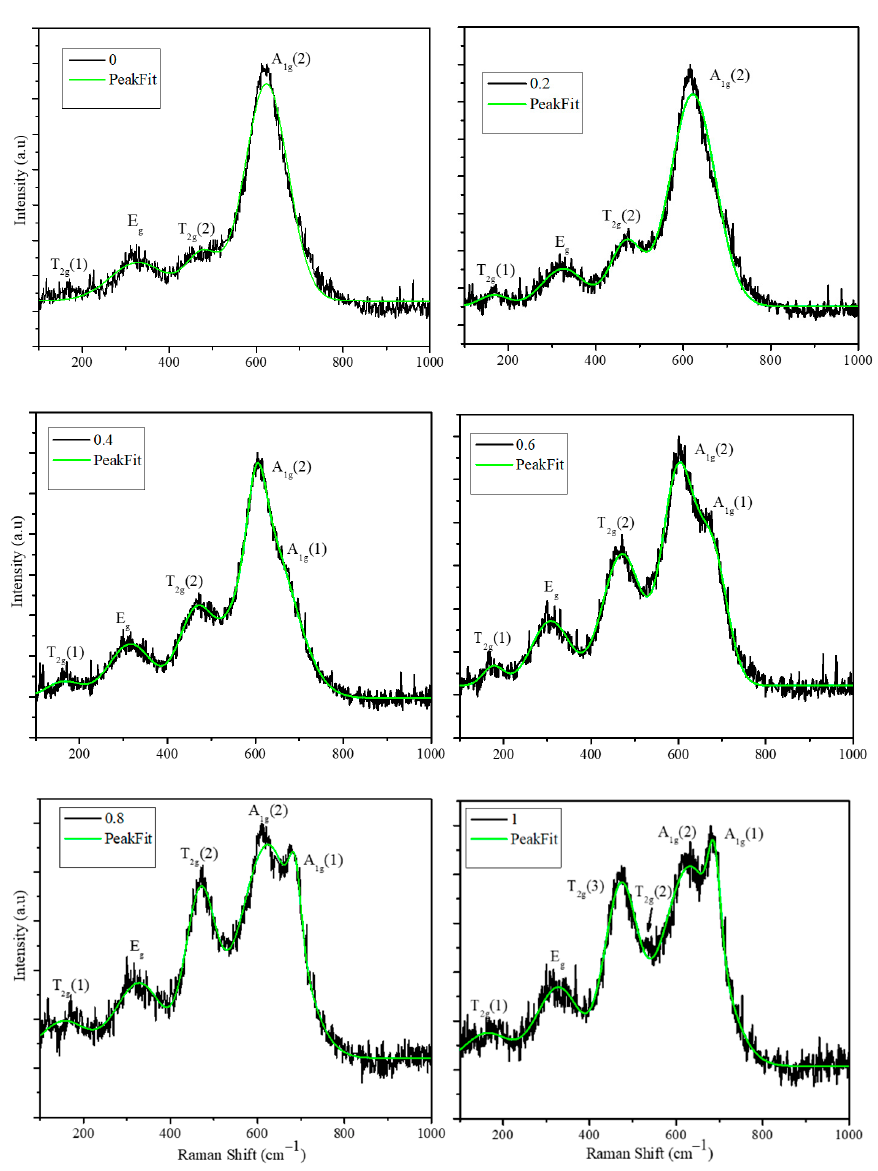
Figure 3. Raman spectra of Co x Mn 1-x Fe 2 O 4 ( x = 0, 0.2, 0.4, 0.6, 0.8, and 1.0) nanoparticles (the composition and fitting of the peaks are marked in the figures; the green line indicates the peak fitting). Raman spectra of the CoFe 2 O 4 phase ( x = 1.0) show characteristic peaks of inverse spinel; the bands at 684 and 633 cm − 1 are assigned to the tetrahedral breathing modes of A 1g (1) and A 1g (2), respectively. A 1g (1) and A 1g (2) correspond to the symmetric stretching of oxygen atoms with respect to Fe and Co ions (Fe-O and Co-O bonds in tetrahedral sites). The intensity ratios of A 1g (1) and A 1g (2) peaks will provide the information about degree of inverse nature of the spinel structure. The asymmetric stretching (T 2g (2)-Fe-O) and bending (T 2g (3)-Fe(Co)-O) are assigned to the bands at 533 and 472 cm − 1 , respectively. The band at 326.7 cm − 1 is assigned to the symmetric bending of Fe(Co)-O. The low intensity peak corresponding to the T 2g mode is assigned to the translation motion of the tetrahe- dron [30]. Raman spectra show inverse spinel structure of CoFe 2 O 4 nanoparticles and rule out the presence of impurity phases like CoO and Fe 2 O 3 , which is in agreement with the XRD patterns obtained from the CoFe 2 O 4 nanoparticles. The Raman spectra of MnFe 2 O 4 ( x = 0.0) are significantly different from the CoFe 2 O 4 nanoparticles; the A 1g peak at 622 cm − 1